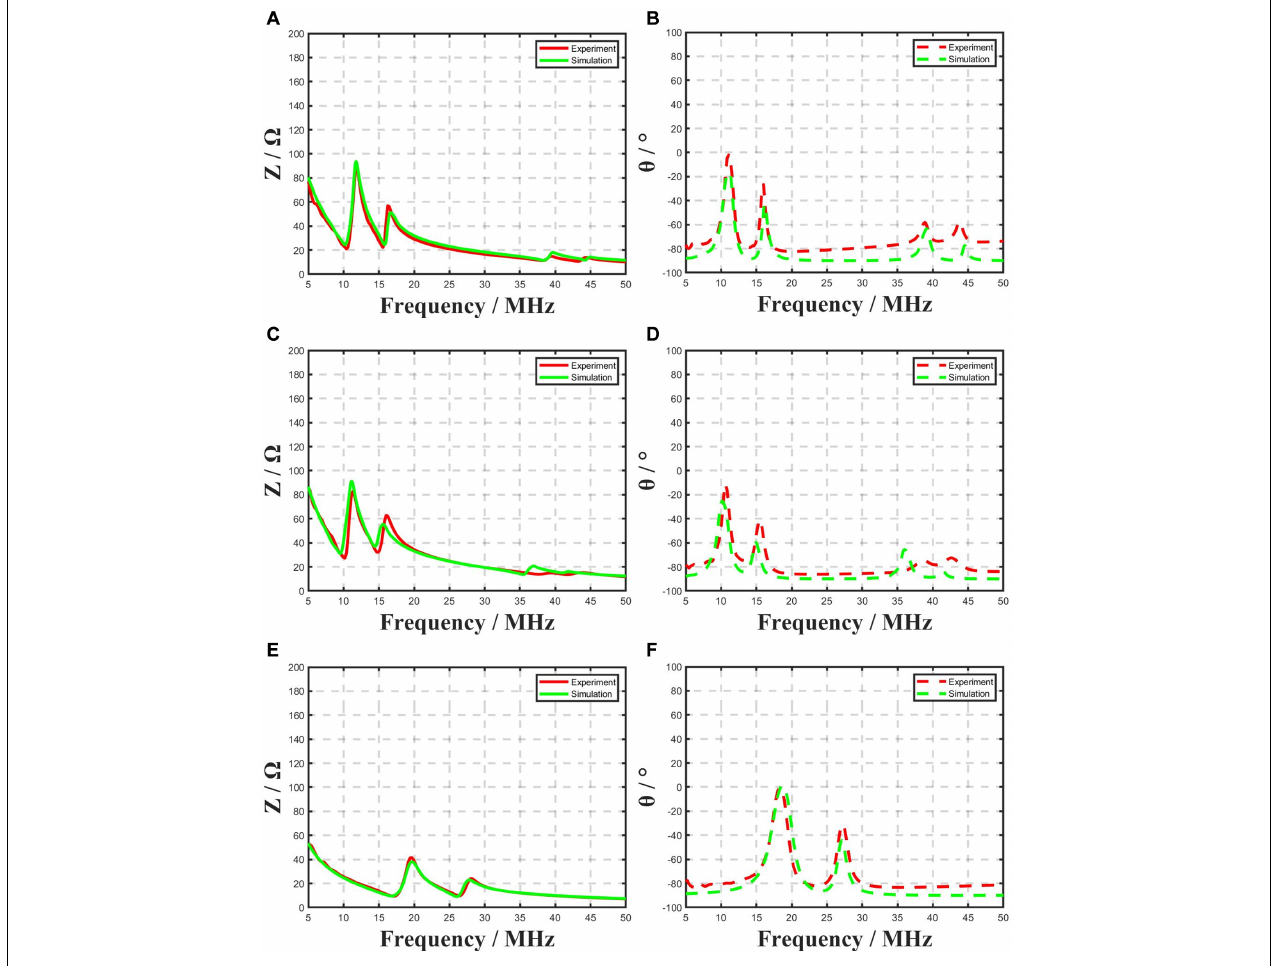
FIGURE 7 | The simulated and measured results of transducers without cable (A) the amplitude of No. 1 transducer (B) the phase of No. 1 transducer (C) the amplitude of No. 2 transducer (D) the phase of No. 2 transducer (E) the amplitude of No. 3 transducer (F) the phase of No. 3 transducer.